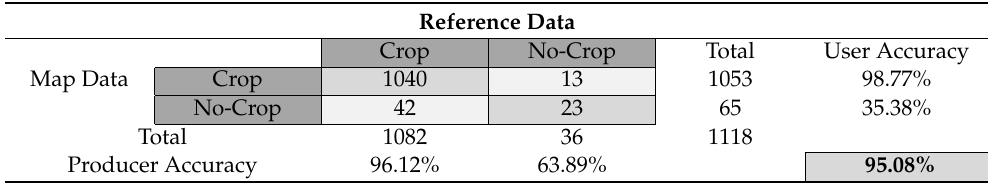
Table 5. The error matrix generated using unbalanced ground collected reference samples.